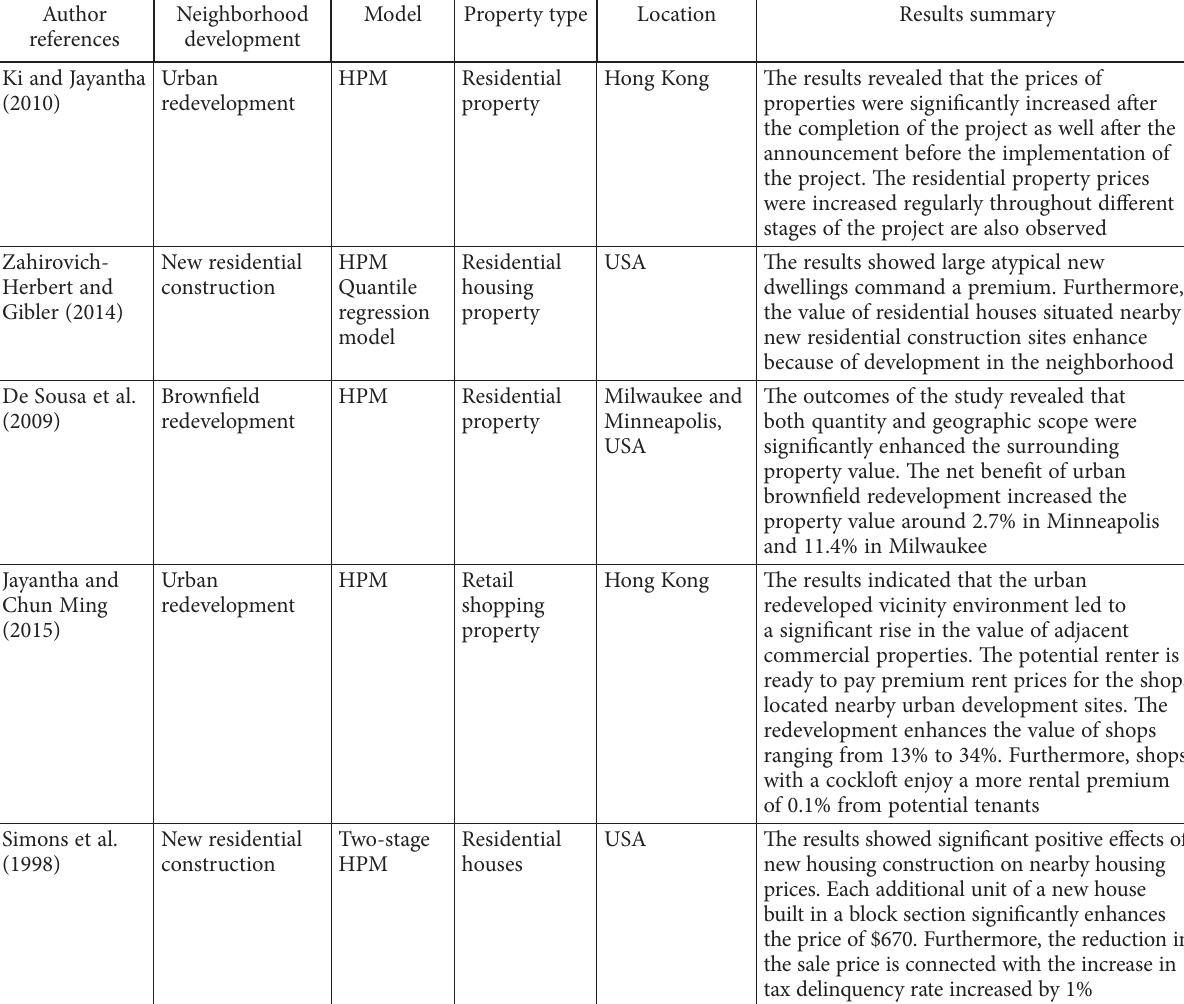
Table 1. Summary of previous hedonic studies on urban redevelopment and property